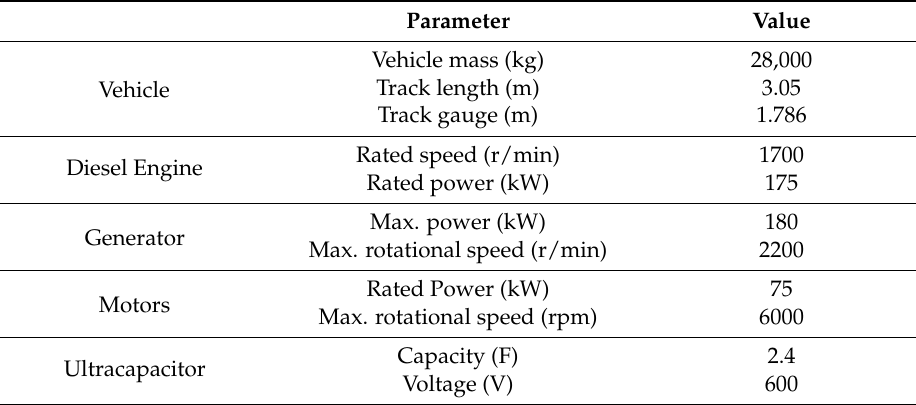
Table 1. Key parameters of the benchmark track-type dozer